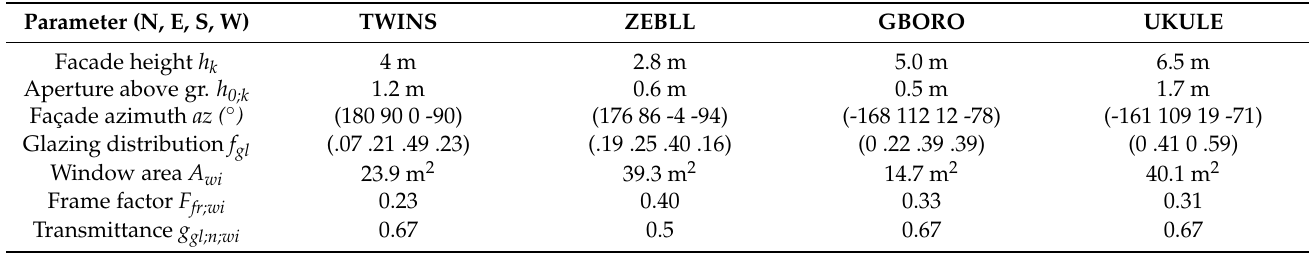
Table A1. Building information and assumptions used to estimate solar irradiance on the facades. Façade glazing distribution and azimuth orientation are given in a list form where the four cardinal directions (N E S W) are (180 90 0 -90)